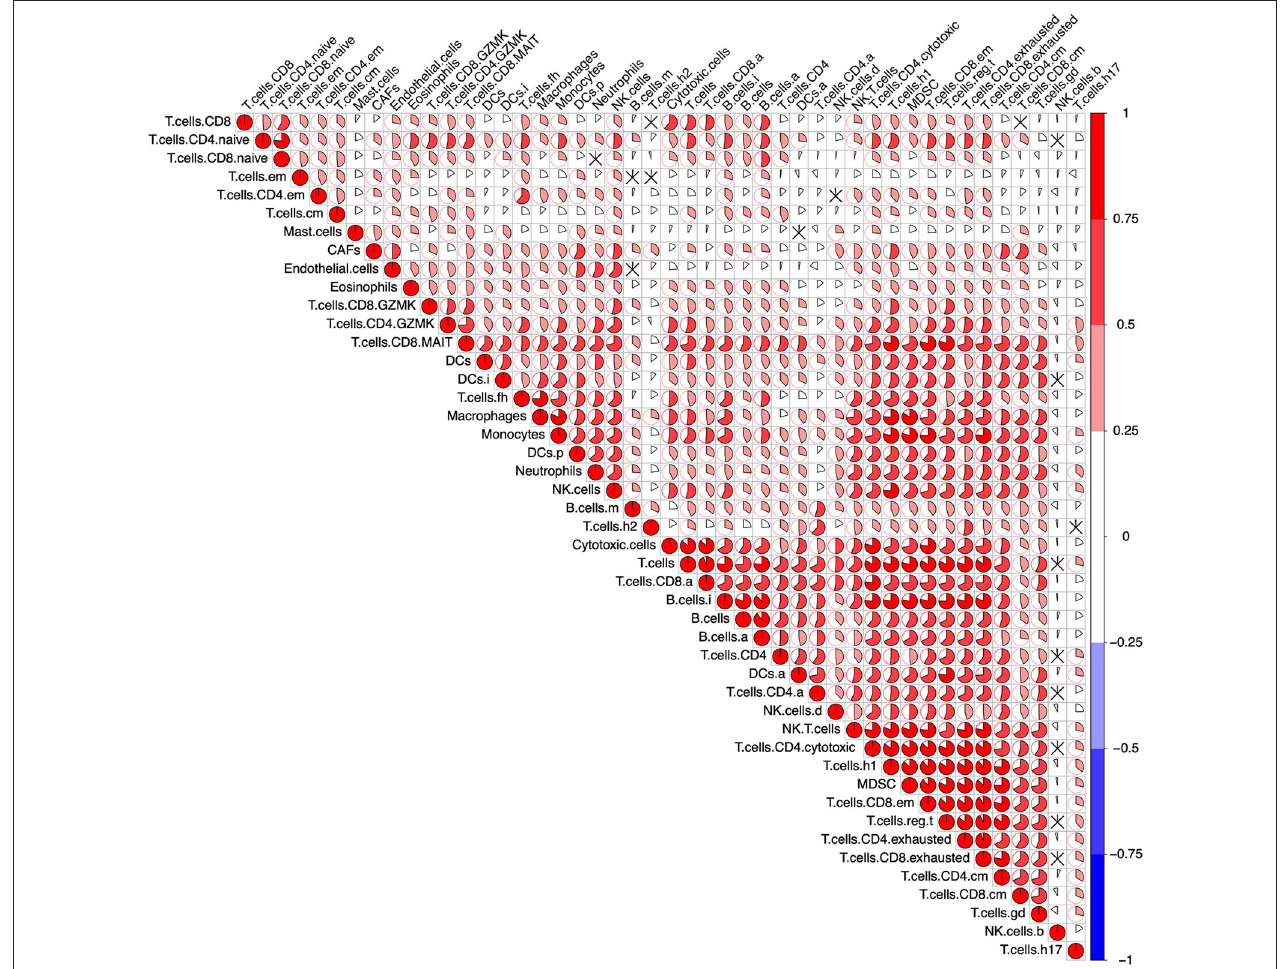
FIGURE 1 | Correlation of the immune cells across the pan-cancer cohort. After calculating the single-sample Gene Set Enrichment Analysis (ssGSEA) score representing the immune cells in the pan-cancer cohort (9,112 patients), a Pearson’s correlation analysis between each immune cell was performed. The result was visualized using the R package “corrplot.” The size of the sector area and the gradient of colors represented the correlation coefficient R. “ × ” means no statistical significance ( P > 0.05).